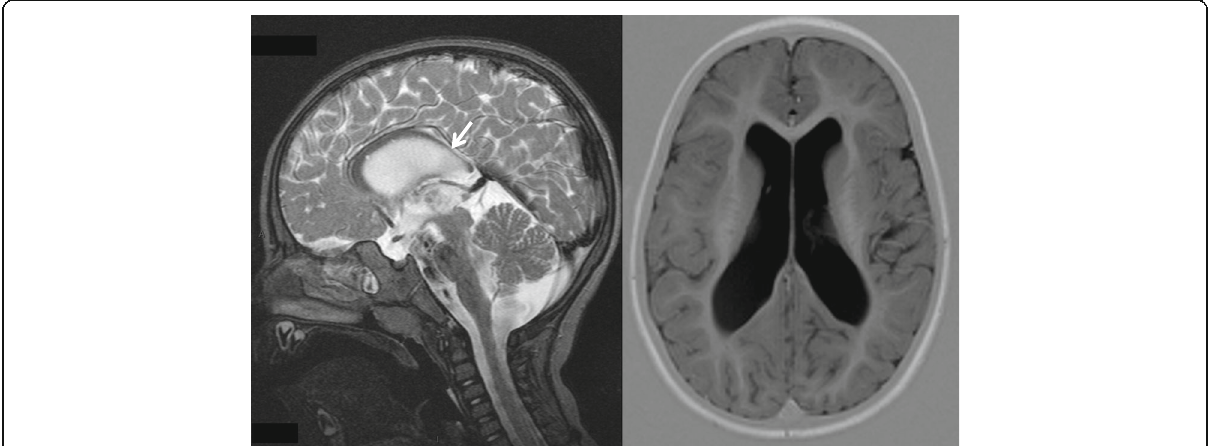
Fig. 1 Brain MRI of the proband at age 2 years and 8 months. Note the normal cortex, temporo-parietal subcortical atrophy bilaterally, enlarged lateral ventricles, the thin corpus callosum predominantly in its caudal portion ( arrow